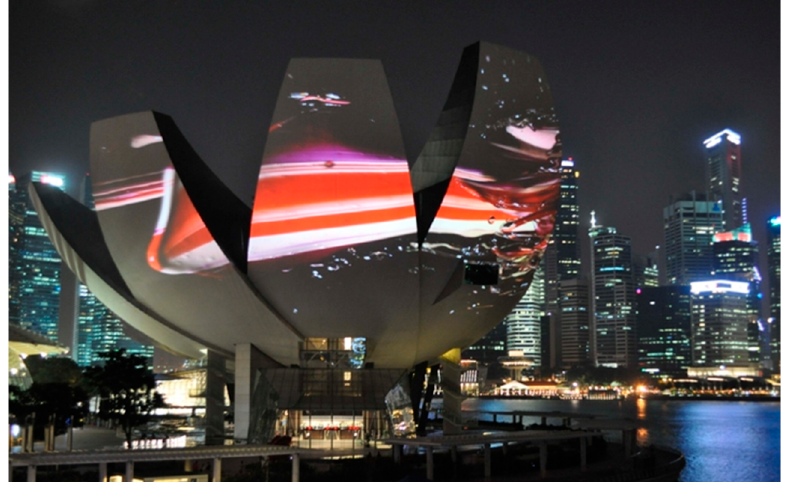
Figure 10. Sound of Ikebana projection mapping at ArtScience Museum in Singapore.